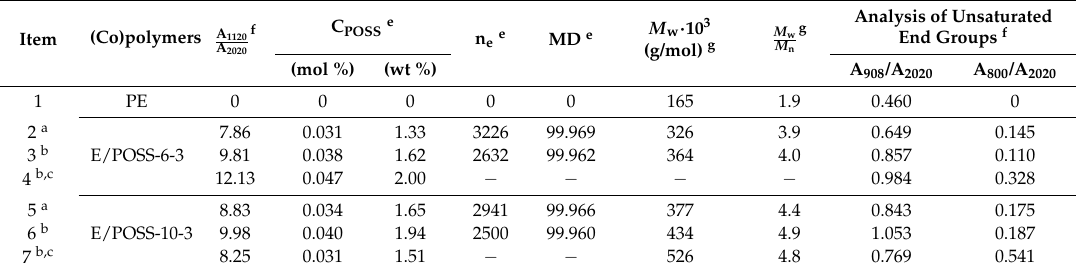
Table 1. Compositions, molecular weights, and analysis of unsaturated end groups of E/POSS copolymers obtained with the use of rac -Et(Ind) 2 ZrCl 2 /MMAO.